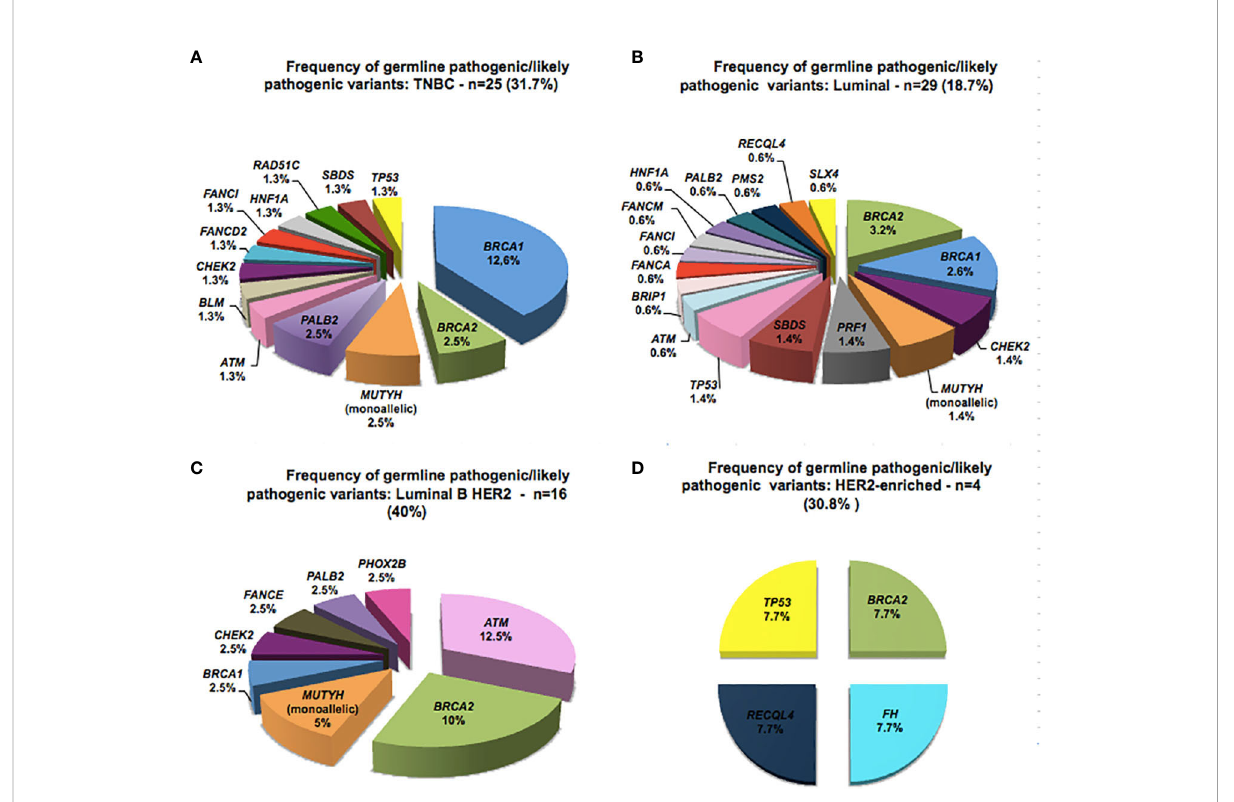
FIGURE 2 Spectrum of germline pathogenic variants detected according to the molecular subtype of breast